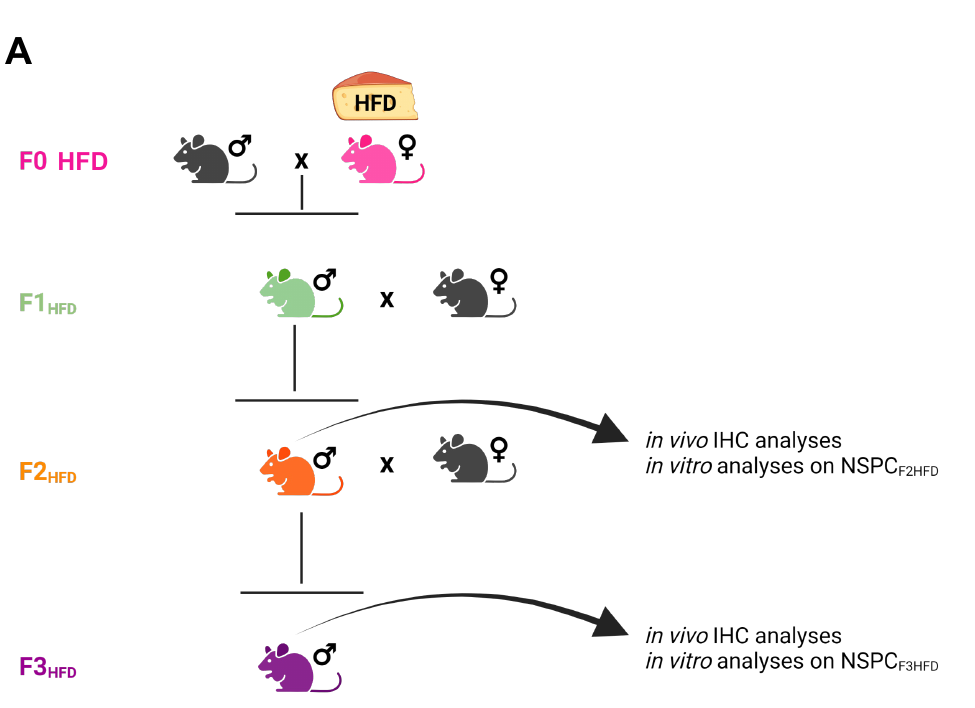
Figure 1. Experimental model. Female mice (F0) were fed with either standard diet (F0 SD ) or high-fat diet (F0 HFD , pink) for 4 weeks before mating with control SD-fed male mice. HFD was maintained during the pregnancy and until the second week of lactation. The offspring (F1 HFD , green) and descendants (F2 HFD , orange and F3 HFD , purple) were always fed with SD. F1 HFD and F2 HFD male mice were mated with SD-fed females to generate, respectively, F2 HFD and F3 HFD mice. All analyses were performed on F2 HFD and F3 HFD brains, and on NSPCs derived from their hippocampi (NSPC F2HFD and NSPC F3HFD , respectively) and cultivated in vitro (see Materials and Methods